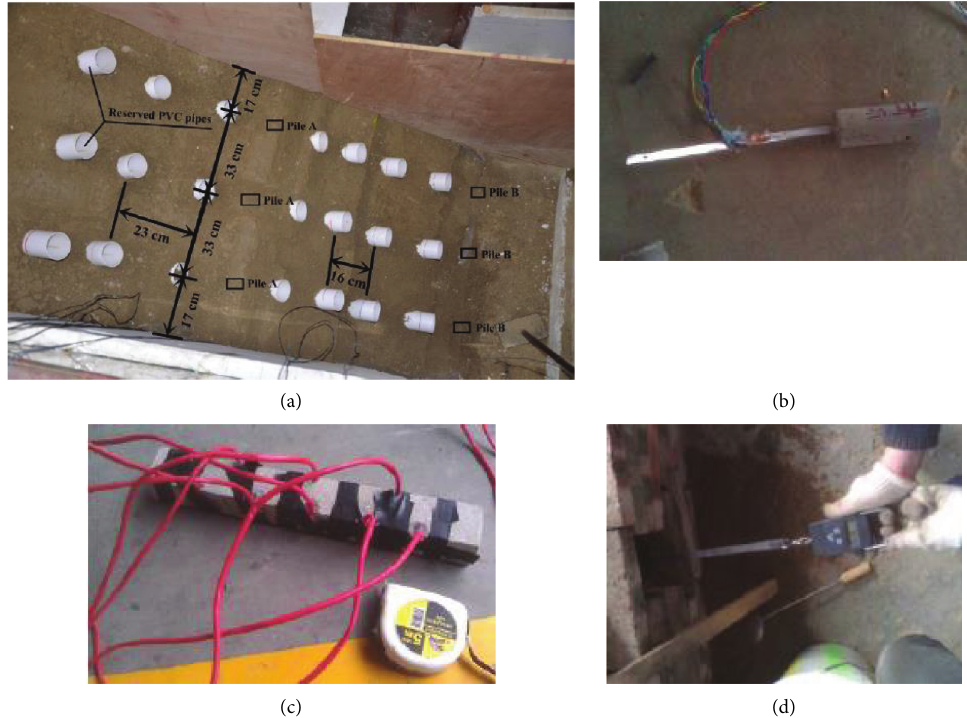
Figure 5: The model slope and the retaining structures. (a) Schematic diagram of the model slope. (b) Prestressed anchor cable. (c) Antisliding pile. (d) Compaction test for the anchor cable.